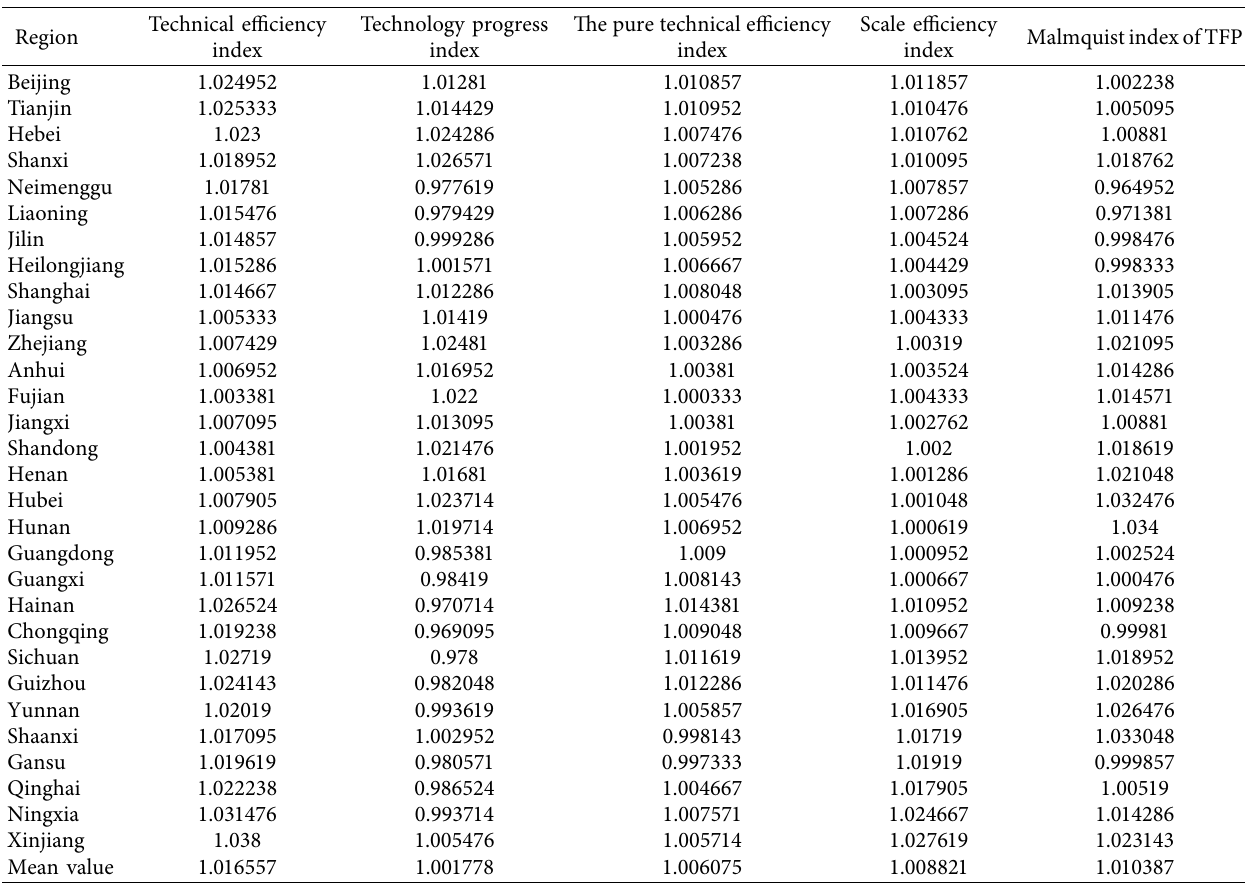
Figure 1: Process of the fsQCA method. Table 1: Total factor productivity index and its decomposition (mean